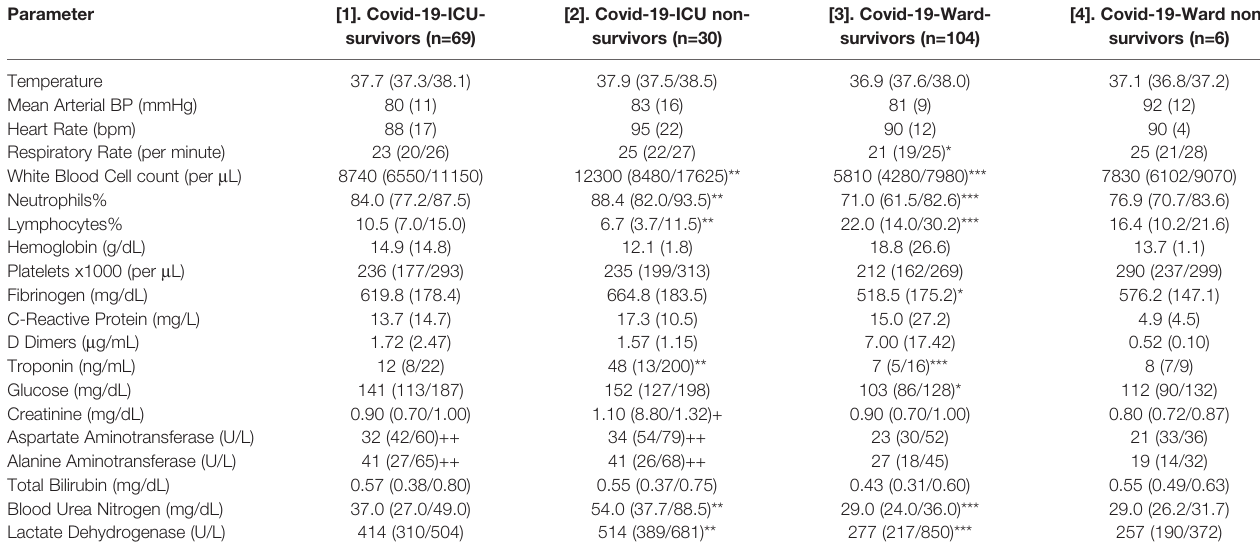
TABLE 2 | Clinical and laboratory data of the study ’ s Covid-19 patients; data are presented as means (standard deviation), median (25 th percentile/75 th percentile) or counts. Parameter